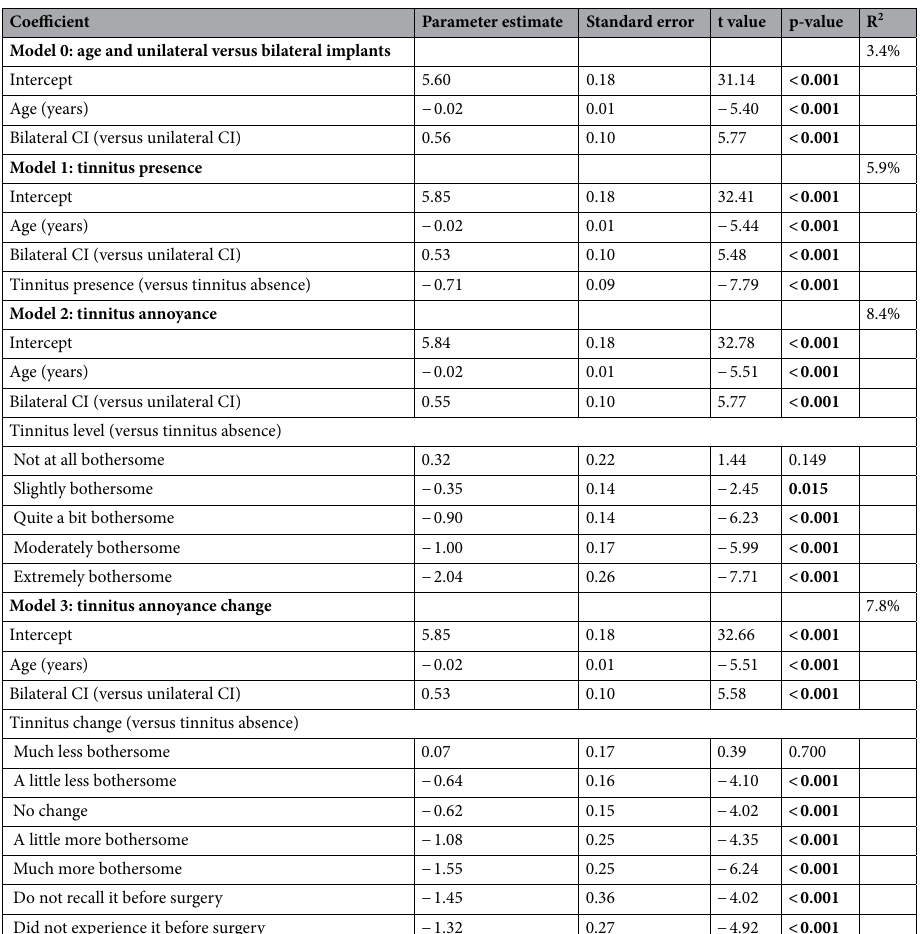
Table 5. Multiple regression models of the SSQ12 scores. Bold indicates statistically significant p < 0.05.